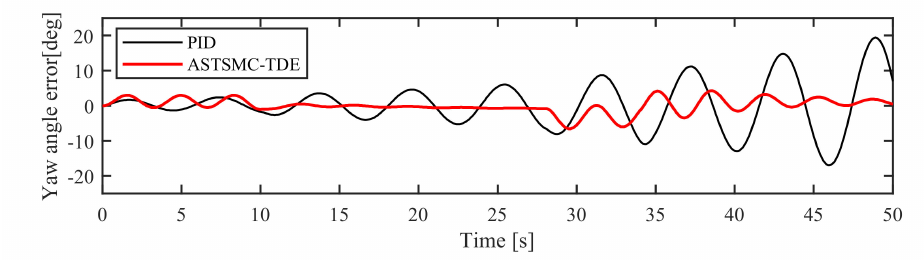
Figure 13. The yaw angle errors in AM